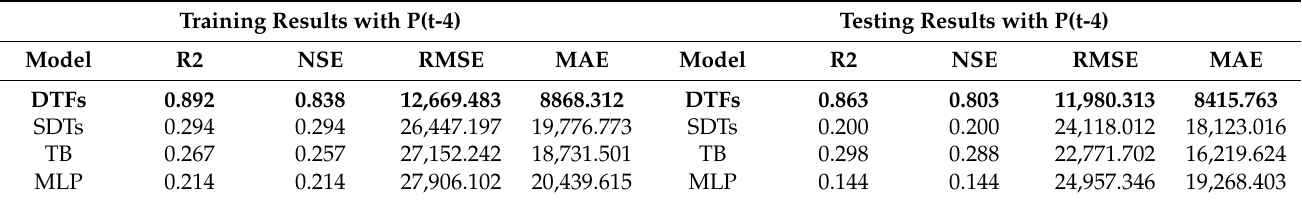
Table 7. Training and testing results with Q(t-4) of different data mining techniques.